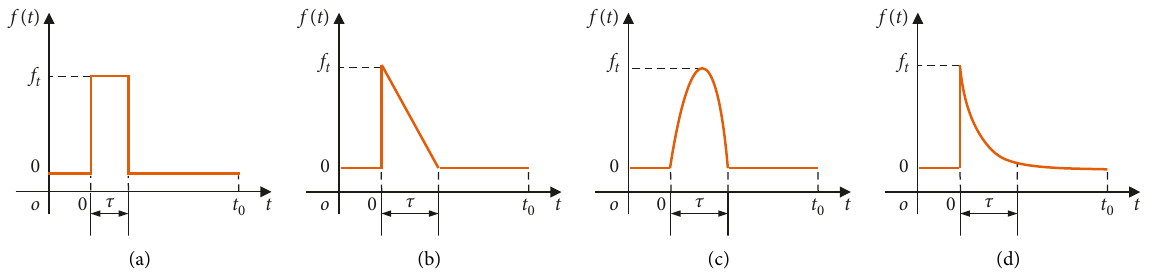
Figure 7: Load pulse shapes. (a) Rectangular pulse; (b) triangular pulse; (c) half-sine pulse; (d) exponential pulse.